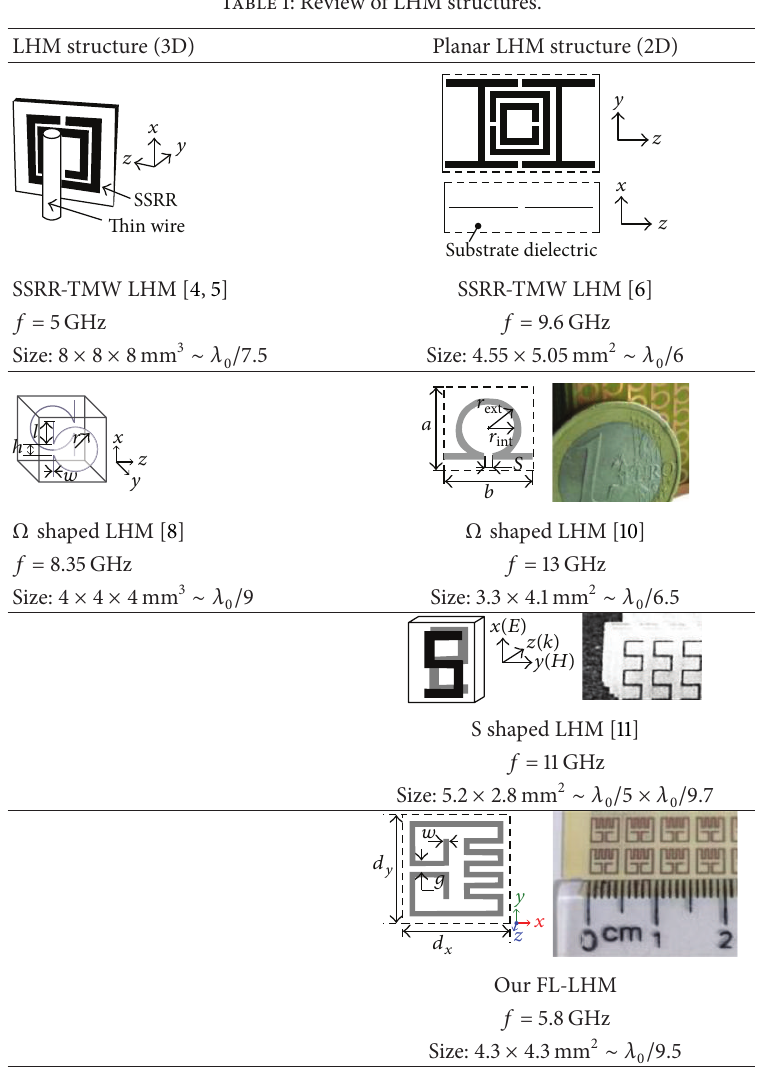
Table 1: Review of LHM